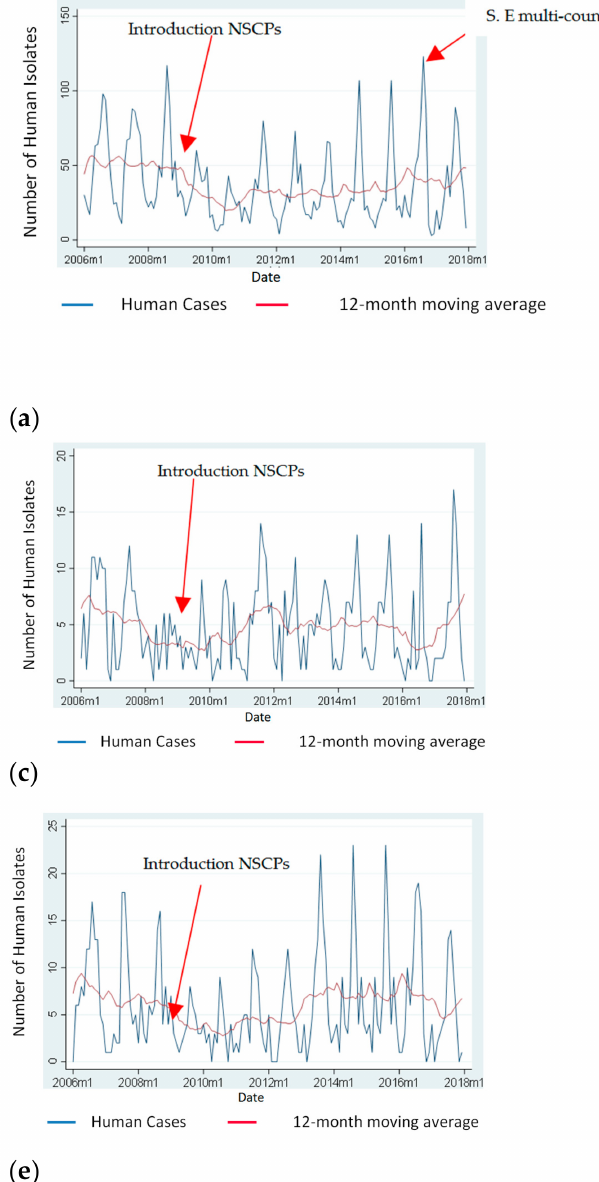
Figure 1. Monthly number of Salmonella spp., S. Enteritidis , S. Typhimurium , monophasic S. Typhimurium and “Control Salmonella serotypes” of human isolates and 12-month moving average. ( a ) Monthly cases attributed to Salmonella spp. and 12-month moving average, Greece, 2006–2017; ( b ) Monthly cases attributed to S. Enteritidis and 12-month moving average, Greece, 2006–2017; ( c ) Monthly cases attributed to S. Typhimurium and 12-month moving average, Greece, 2006–2017; ( d ) Monthly cases attributed to monophasic S. Typhimurium and 12-month moving average, Greece, 2012–2017 (Data on monophasic S. Typhimurium were only available since 2012 and the introduction of the NSCPs was much earlier in 2009, therefore there is no arrow in panel ( d ); ( e ) Monthly cases attributed to “Control Salmonella serotypes” (serotypes detected from human cases between 2004 and 2017 but were either not detected or rarely detected, maximum of two times each, in poultry) and 12-month moving average, Greece,